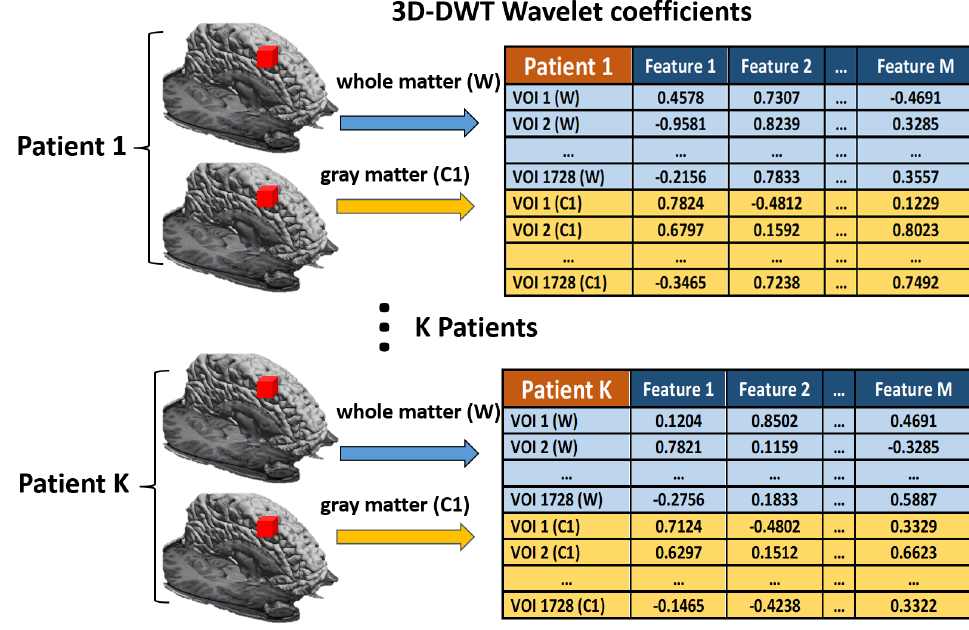
Figure 5. Feature matrix of 3D-DWT wavelet coefficients for each specific VOI in whole and gray